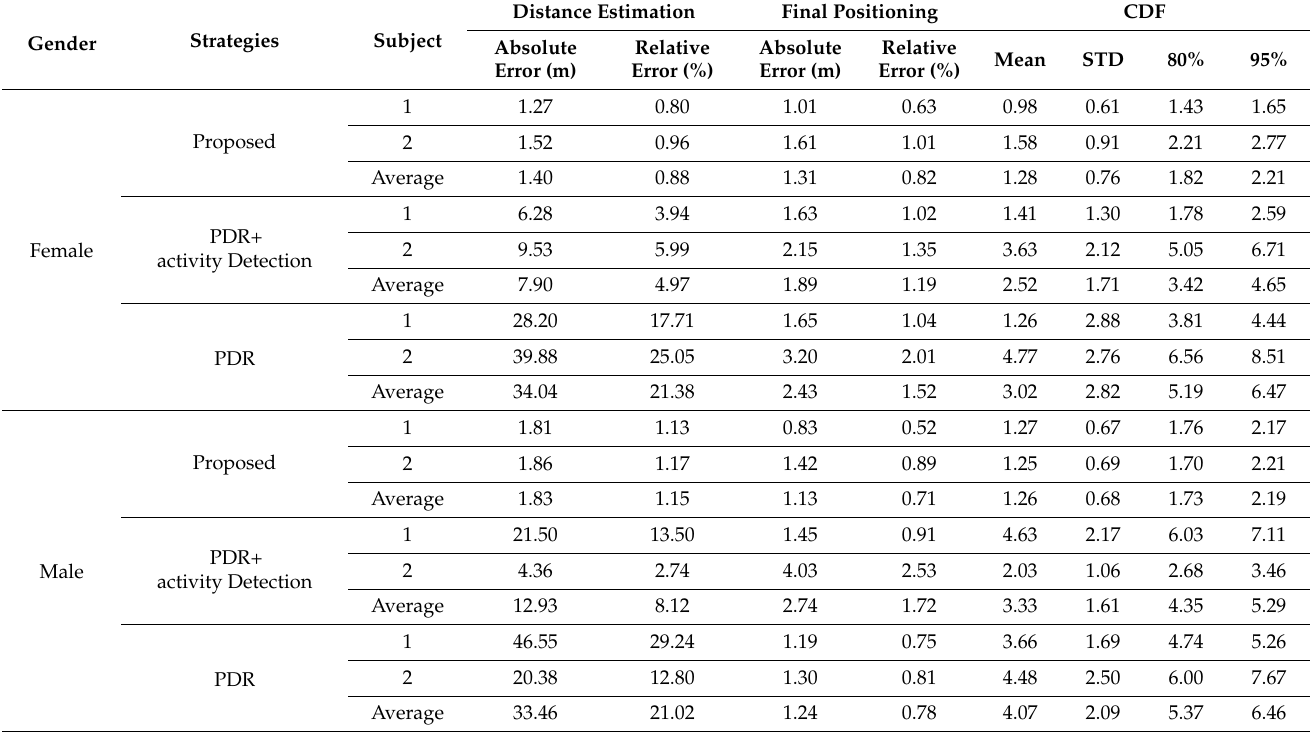
Table 10. Positioning results of the texting mode.